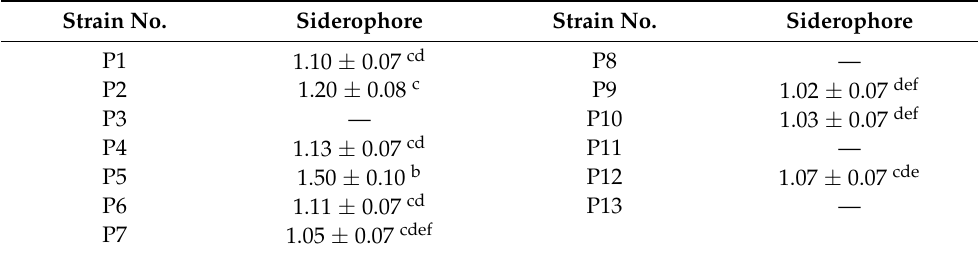
Table 6. Ability to produce siderophore of phosphorus-dissolving bacteria. Strain No. Siderophore Strain